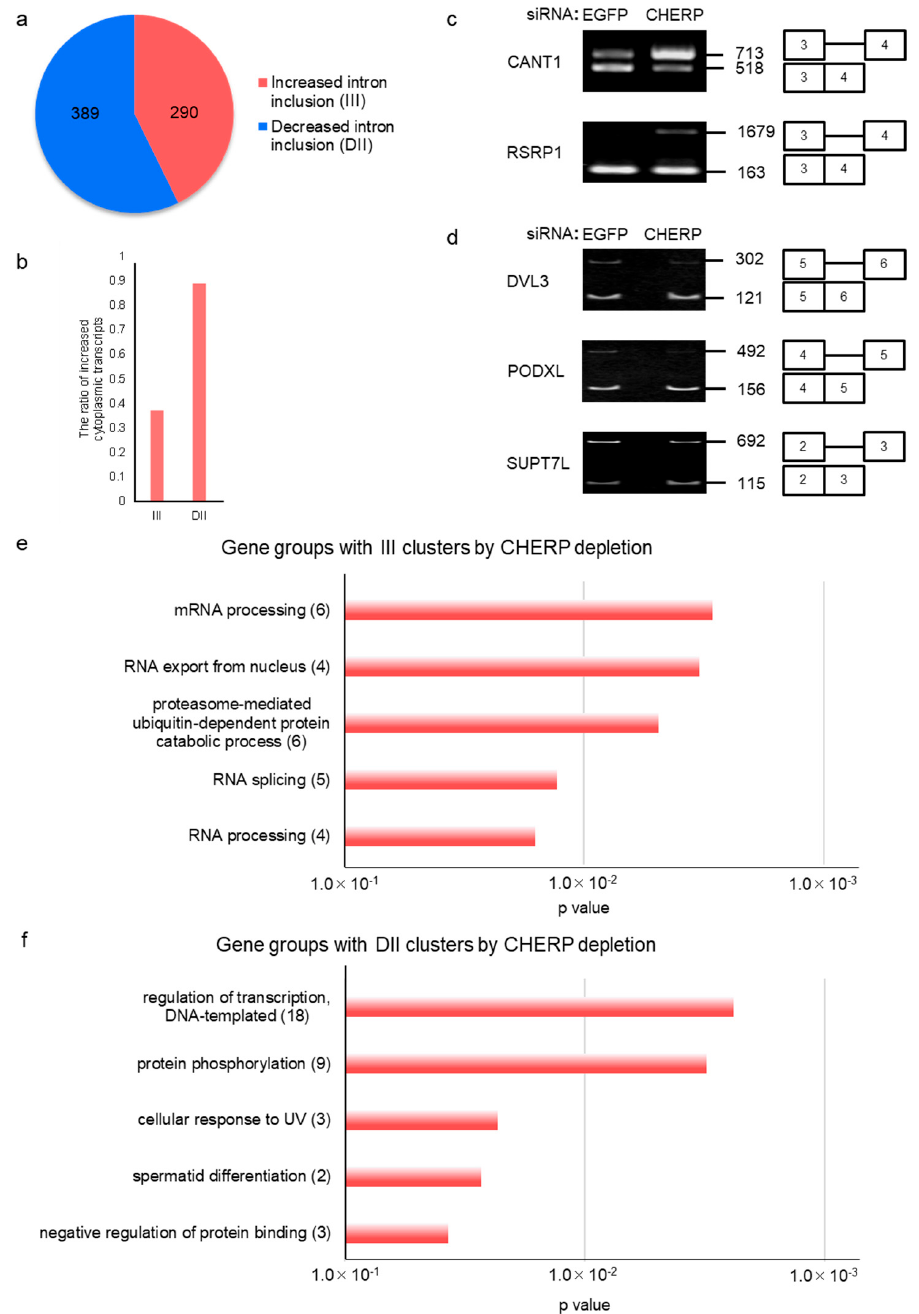
Figure 2. CHERP regulates transcripts with increased intron inclusions (III) and decreased intron inclusions (DII). ( a ) Number of increased and decreased intron inclusion events after CHERP deple- tion. Events with FDR < 0.05 were considered statistically significant. ( b ) Cytoplasmic/nuclear ratios